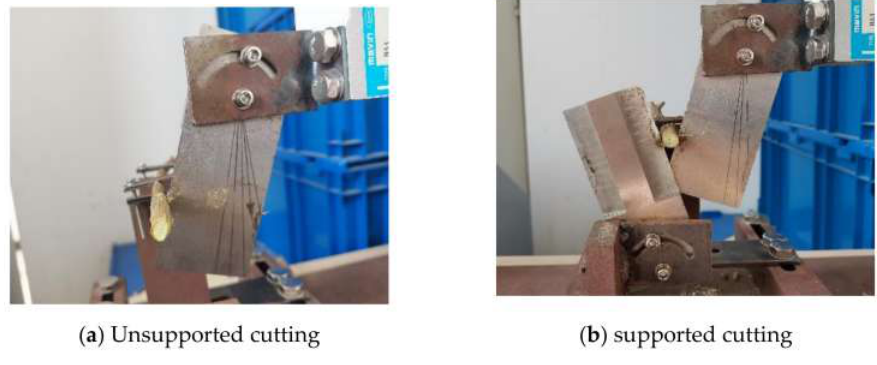
Figure 2. Cutting type.